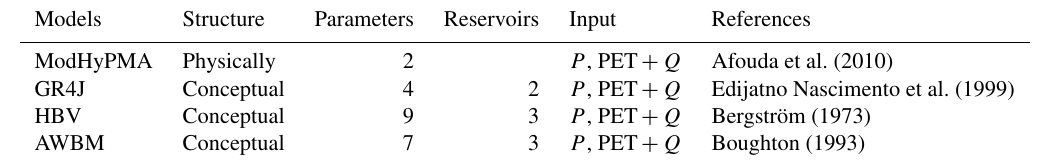
Table 1. Characteristics of the rainfall-runoff models used.